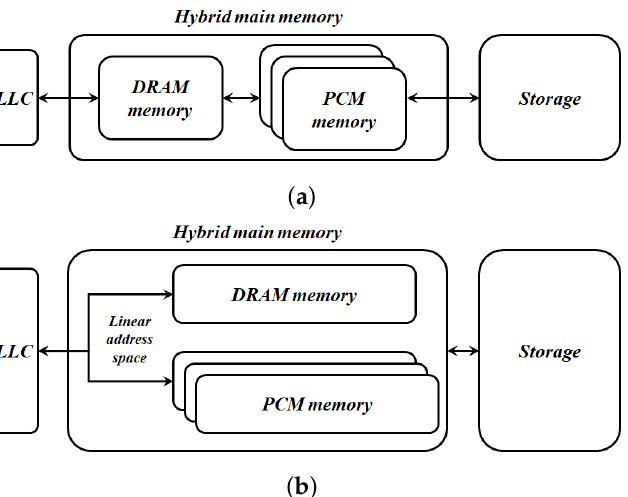
Figure 1. Organization methods of the hybrid main memory. ( a ) Hierarchical organization. ( b ) Paral- lel